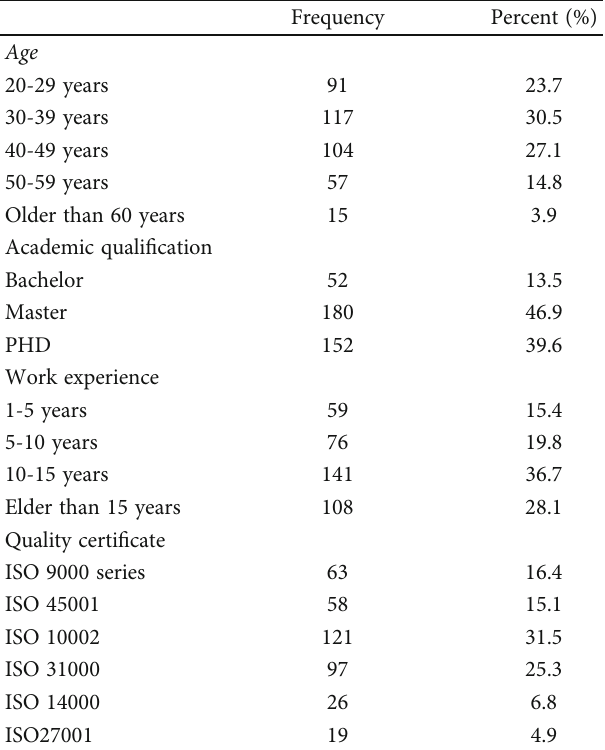
Table 4: The demographic data of